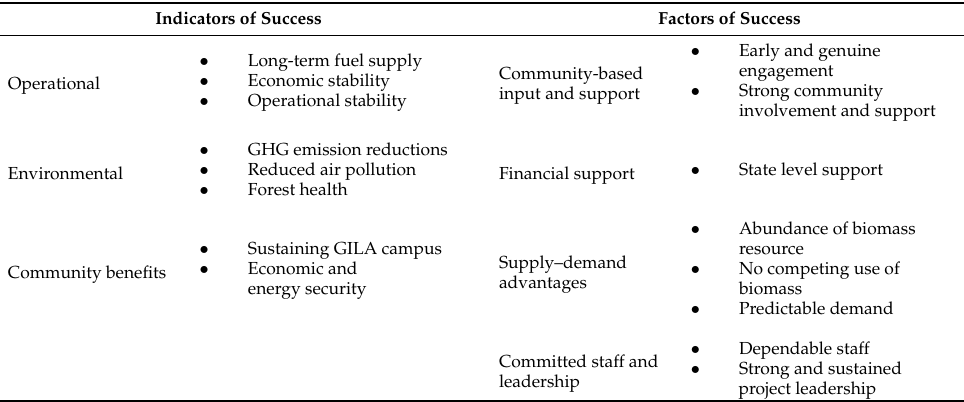
Table 2. Indicators and enabling factors of project